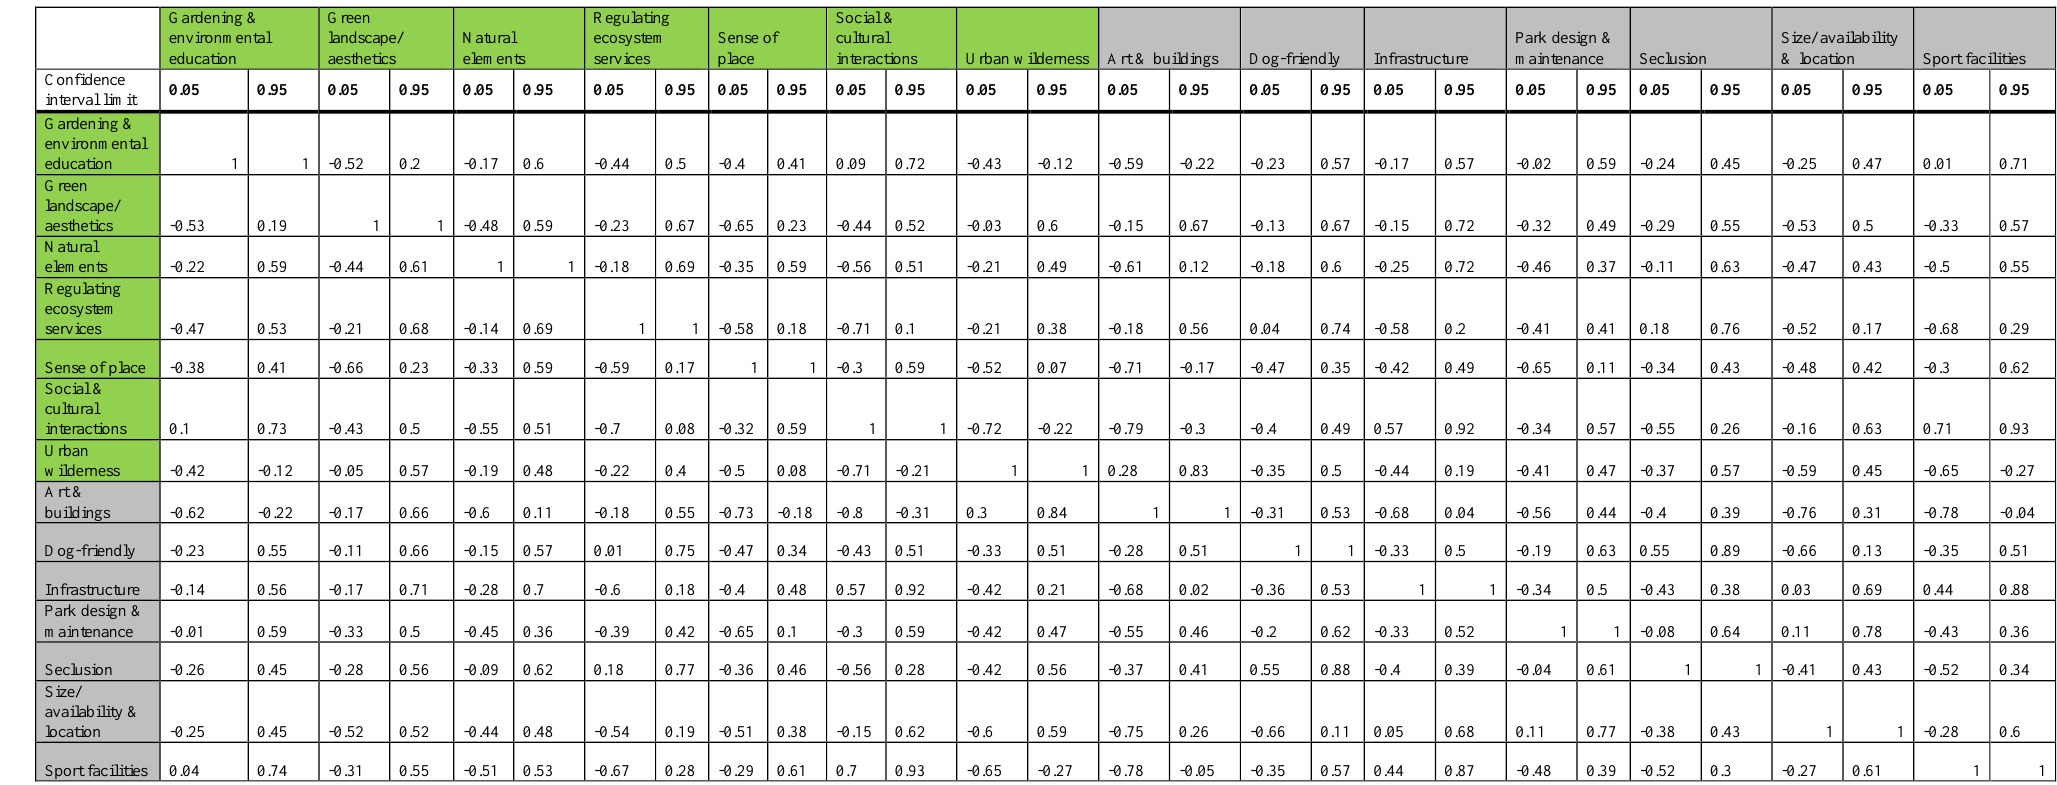
Table A1.4: Lower and upper confidence intervals for 1000 bootstrapped correlation coefficients for weighted Spearman’s rank-correlation of benefits in urban parks. Confidence intervals that do not include zeros (= are below or above zero) are suggesting significant correlations ( p<0.05